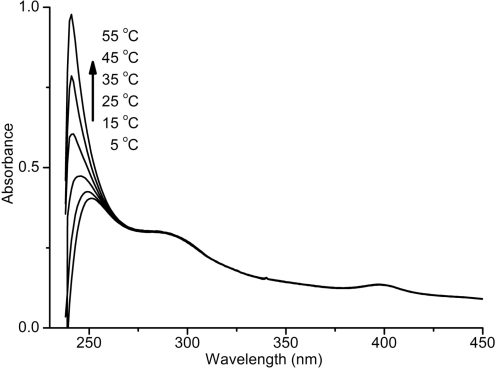
UV-vis spectral changes of PAT-2 from 5 to 55 °C measured in CHCl3 [PAT-2]= 1.8 × 10−5.